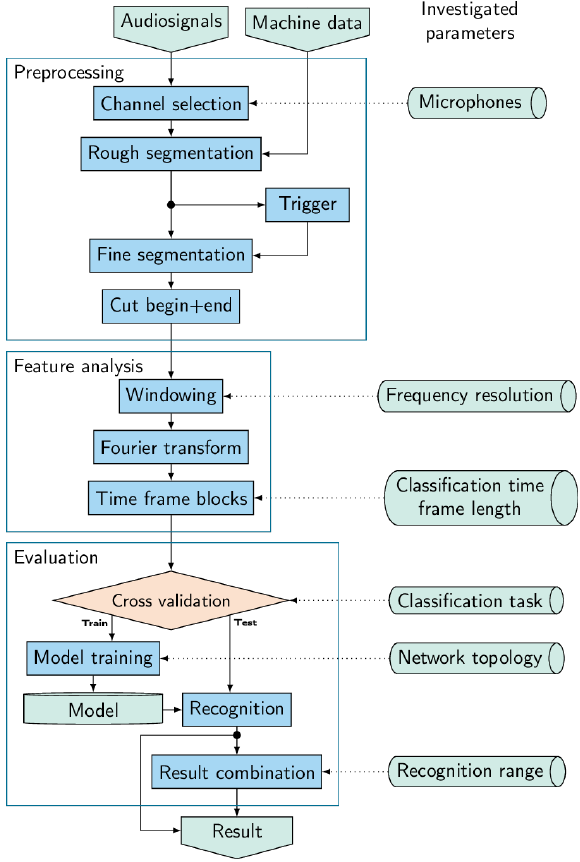
Figure 2. Dataflow graph for pre-processing, feature analysis and evaluation. Table 2. Class labels for six-class and four-class classification